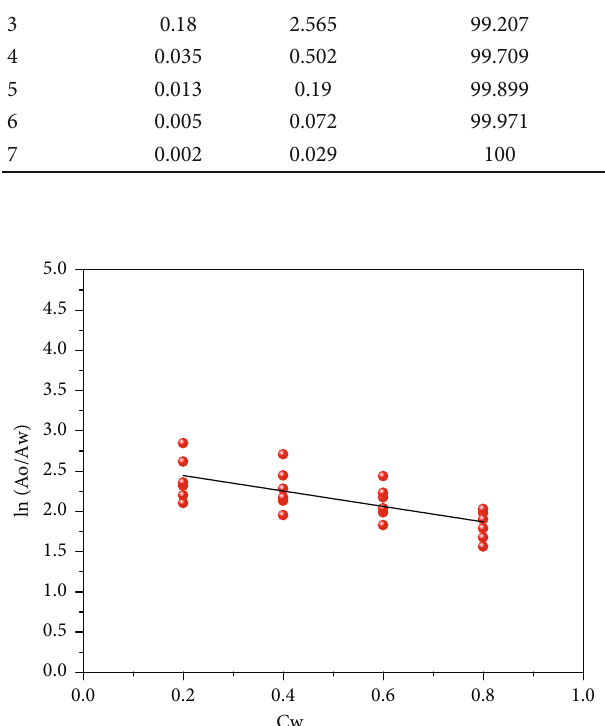
Figure 8: Intersection diagram of water cut and amplitude